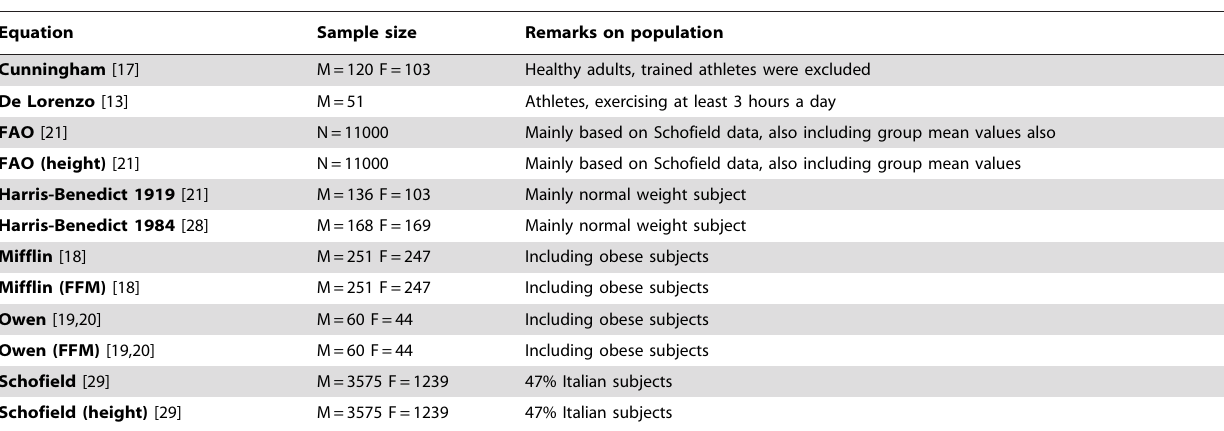
Table 1. Equations evaluated in this